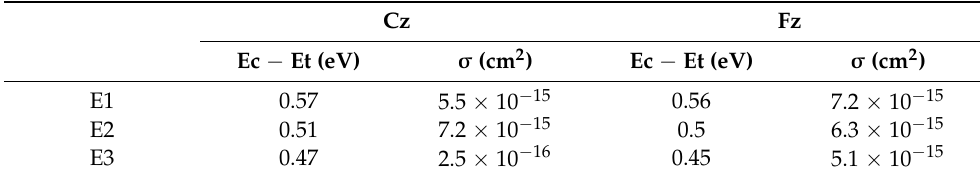
The DLTS spectra change due to the 950 ◦ C pre-annealing before the RPD process is shown in Figure 3. The signal was obtained from Cz-Si, with the peak intensity increasing owing to the annealing process. The defect concentration induced by the RPD process increased due to the annealing before the RPD